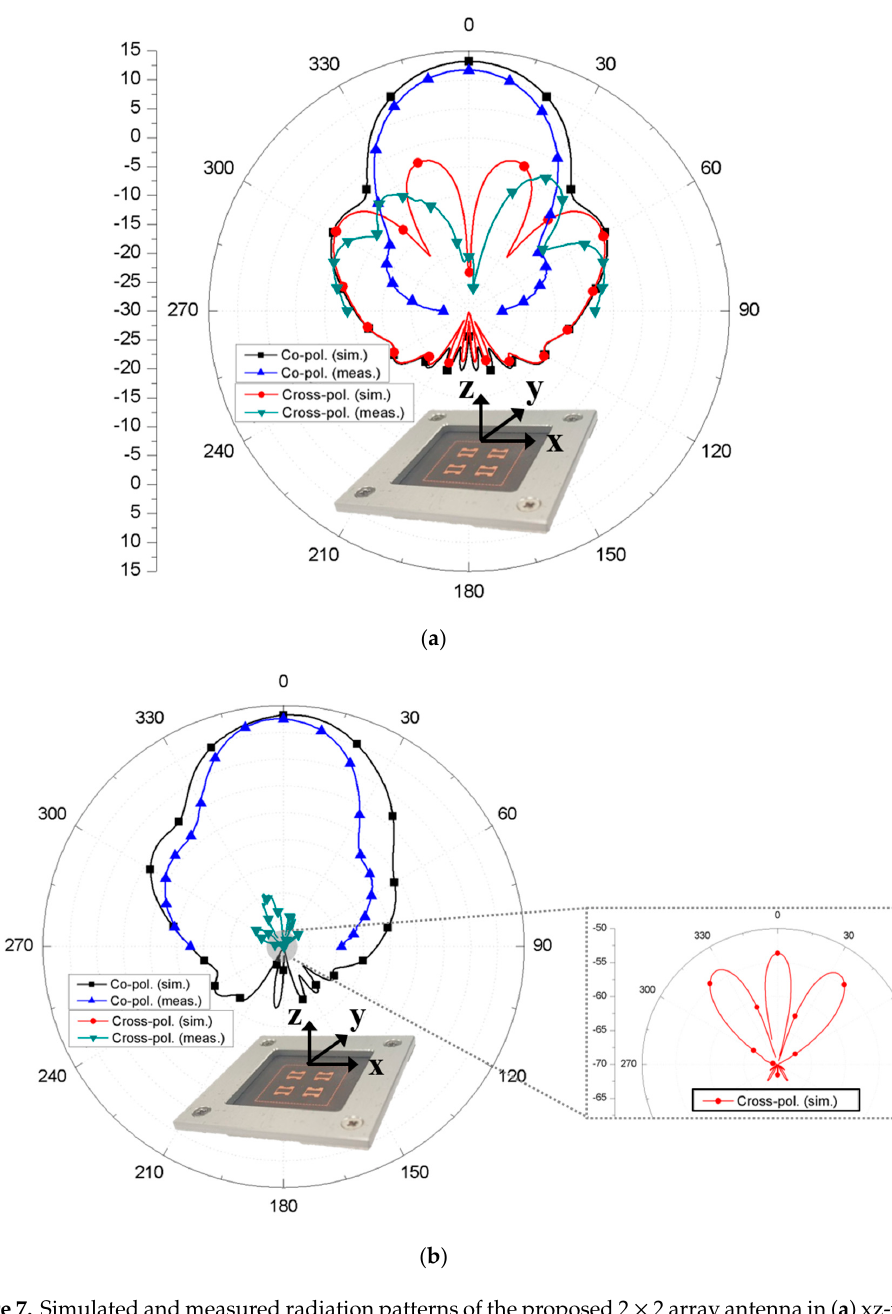
Figure 7. Simulated and measured radiation patterns of the proposed 2 × 2 array antenna in ( a ) xz-plane and ( b ) yz-plane at 28 GHz.